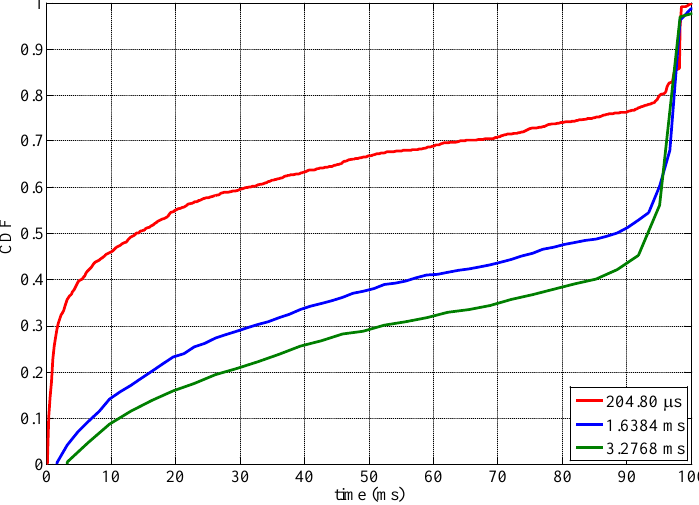
Figure 8. E ff ect of time resolution on empirical CDF of channel ‘1’. Figure 8. Effect of time resolution on empirical CDF of channel ‘1’. Figure 8. Effect of time resolution on empirical CDF of channel ‘1’.